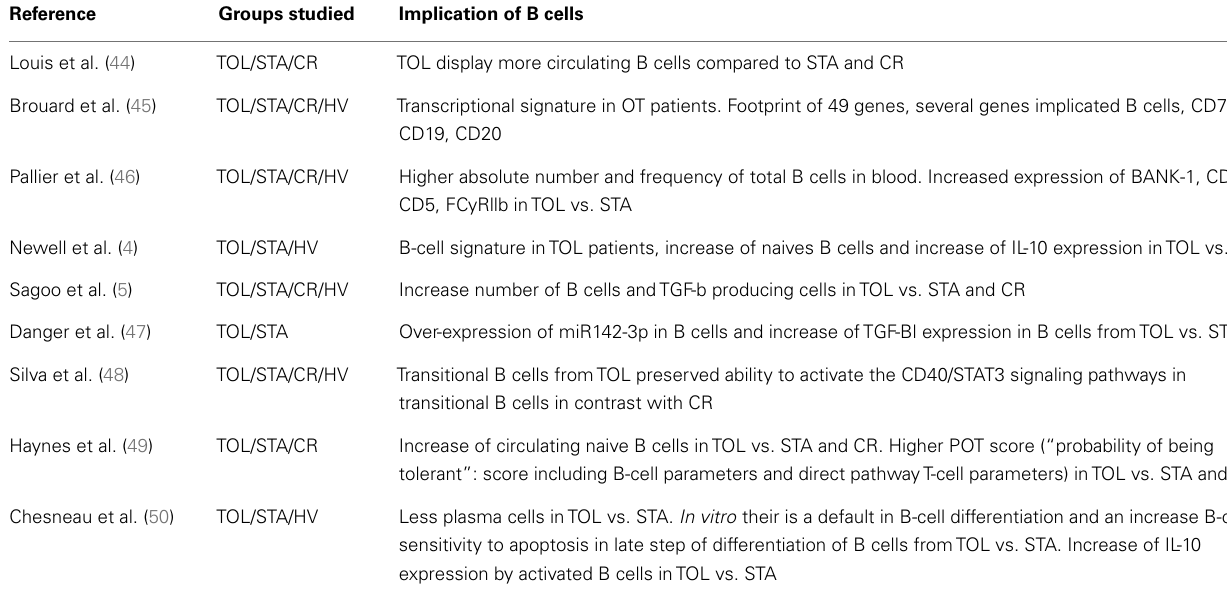
Table 2 | Summary table of studies demonstrating the implication of B cells in kidney-transplant operational